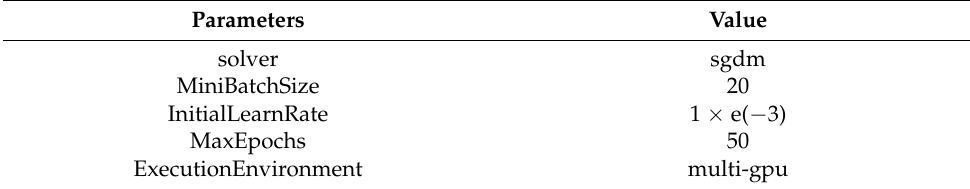
Table 9. The training parameters for the examined CNN models.